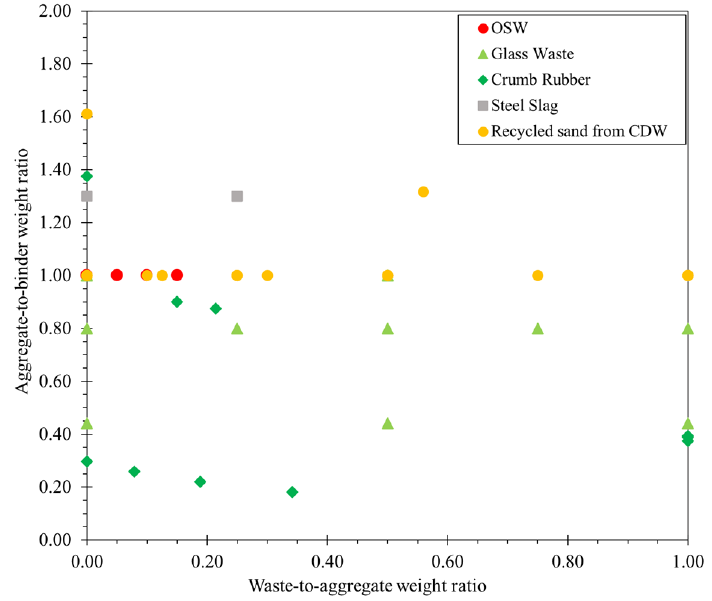
Figure 9. Aggregate-to-binder weight ratio and waste-to-total aggregate weight obtained from 3DPCC mixtures using unconventional aggregates (data source: [65,66,68,70 – 72,74 – 85].